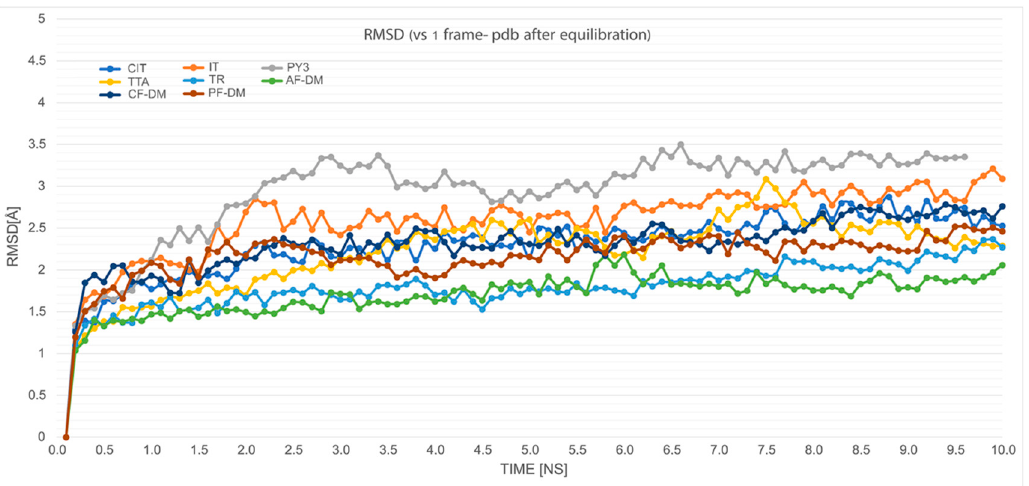
Figure 10. RMSD value changes measured in [Å] vs. frame 1, during 10 ns simulation of the unbound protein models described herein.